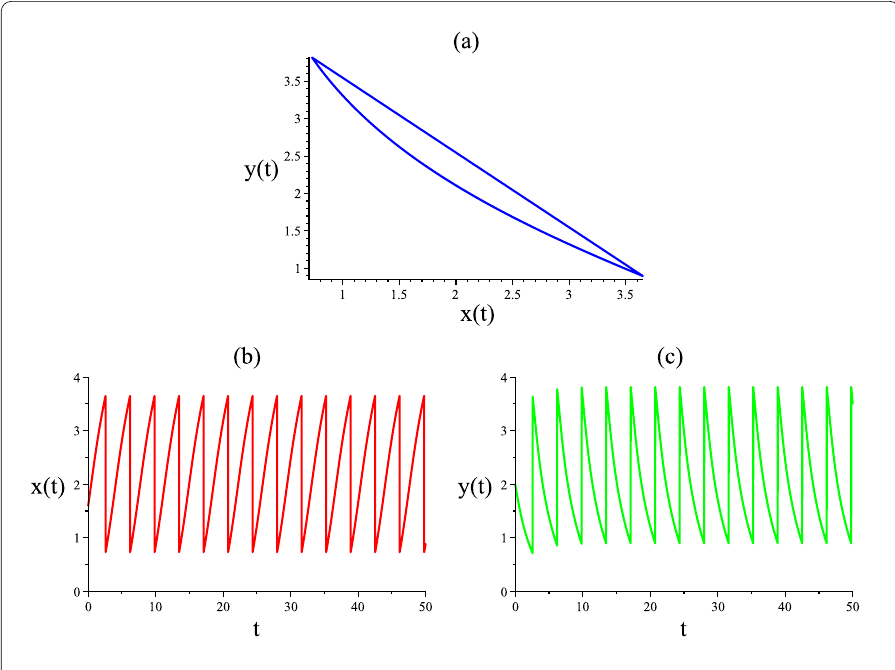
Figure 9 The numerical simulation of system (1). (a) Phase portrait of x ( t ) and y ( t ) on τ = 3.65. (b) Time series of x ( t ). (c) Time series of y ( t